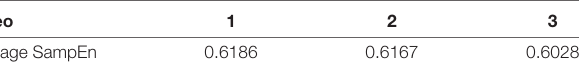
FIGURE 7 | Average SampEn of three videos in session 1.